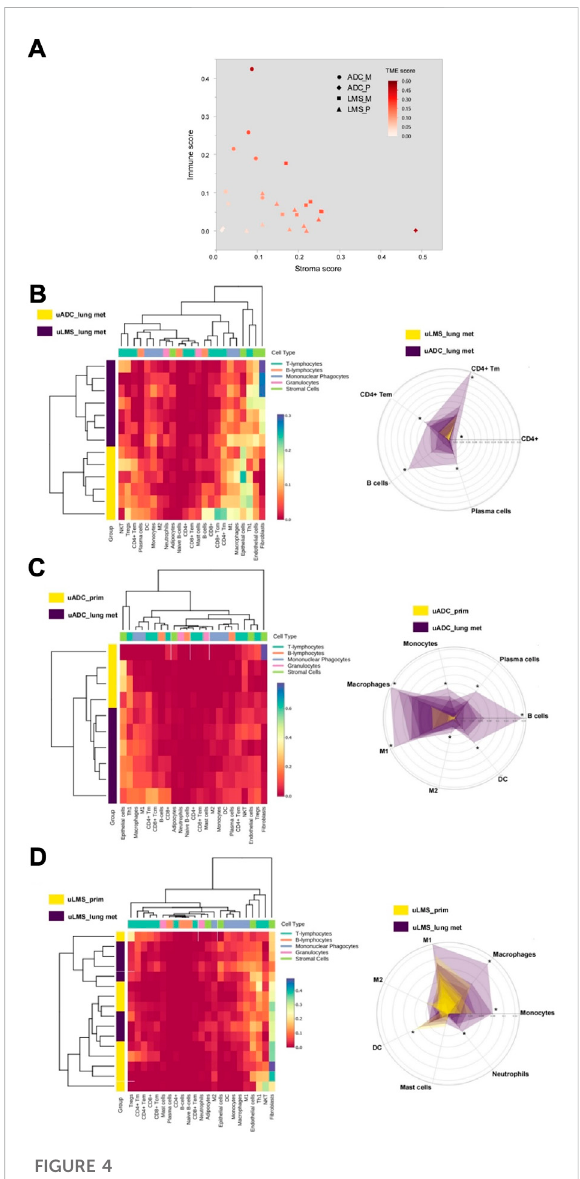
metastatic and paired tumors. (A) Estimation of immune and stromal cellular content. The TME (Tumor Microenvironment) score is the sum of the immune and stromal score (B – D) Left panels, hierarchical clustering of tumor samples and immune/ stromal cell types based on the relative abundance score estimated with HTG EdgeSeq Reveal Immunophenotyping Signatures. Right panels, radar charts displaying the immunophenotyping signatures which showed the major differences in each comparison (*, denotes statistically signi fi cant differences in scores for relative